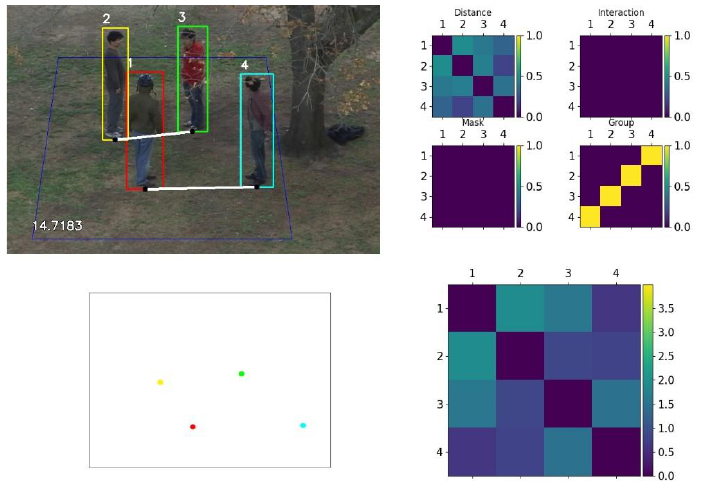
Figure 10. Full system result of UTI interaction dataset at t 1